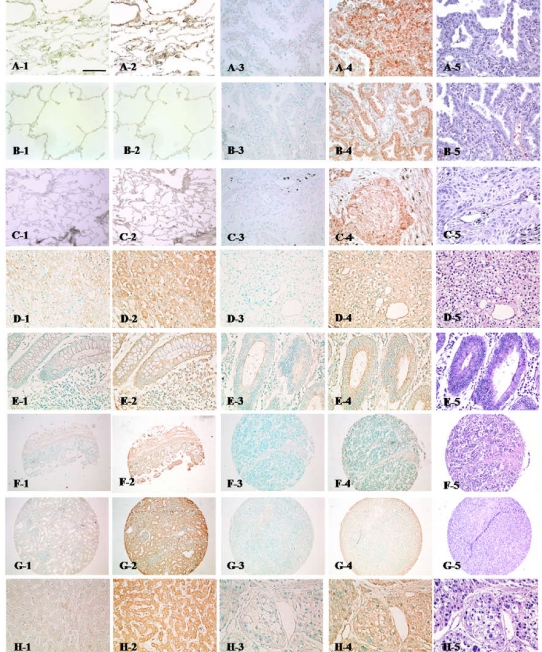
Figure 3. Immunohistochemical staining of QSOX1 in various cancer tissues and their corresponding normal tissues. QSOX1 protein expressions in lung cancer tissues were confirmed by immunohistochemistry on tissue microarray slides. Column 1 is the slides stained without antibody for corresponding normal tissues of column 2 (negative control); column 2, stained with anti-QSOX1 antibody for each organ; column 3, stained without antibody (negative control) for column 4; column 4, stained with anti-QSOX1 antibody on cancer tissues for each organ. Column 5 is H&E staining of column 4 at the next serial section. Scale bar, 100 µ m. ( A , B ) Lung adenocarcinoma, ( C ) squamous cell lung cancer, ( D ) pheochromocytoma in adrenal gland, ( E ) adenocarcinoma in colon, ( F ) large cell lymphoma in ileum, ( G ) renal cell carcinoma, and ( H ) hepatocellular